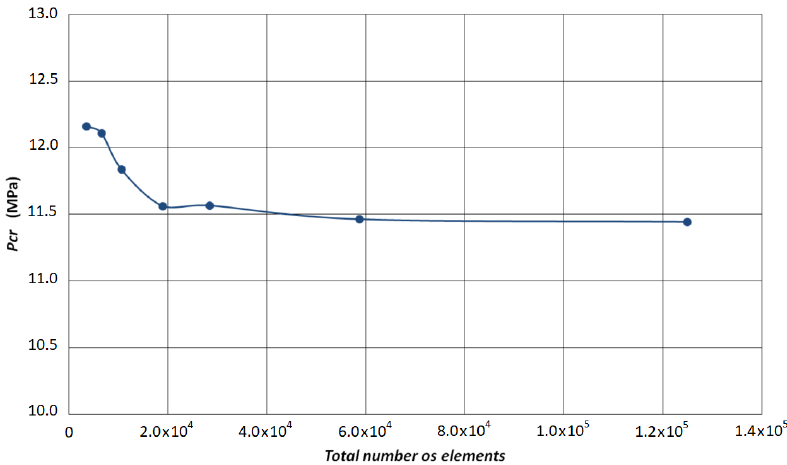
Figure 8. Convergence analysis for the conventional stiffened shell.